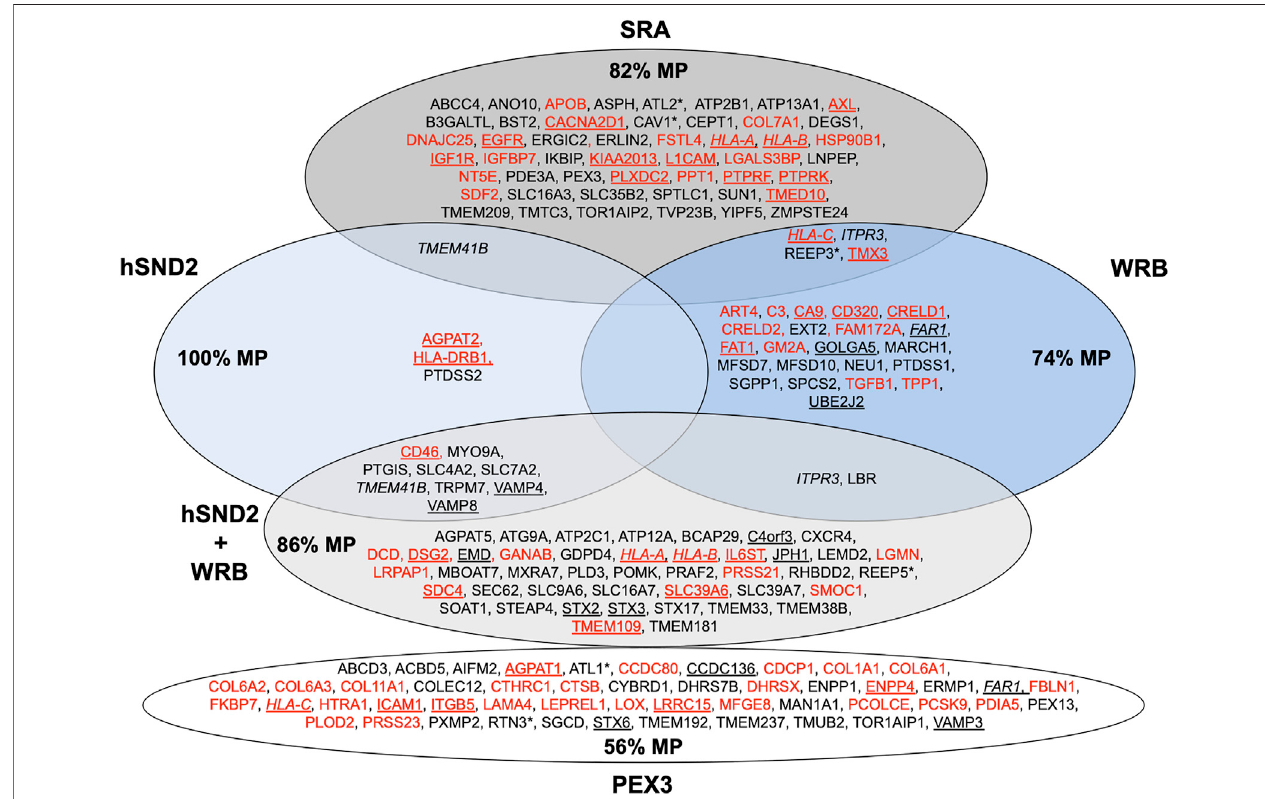
FIGURE 6 | Venn diagram for components for precursor targeting to the human ER membrane and their clients. The diagram summarizes precursors with SP (in red)orTMH(inblack),whicharedestinedtothesecretorypathwayandwerenegativelyaffectedbytheindicateddepletioninHeLacells(Tirincsietal.,2022b)orbyPEX3 depletioninHeLacellsandafterPEX3knock-outinZellwegerpatient fi broblasts(Zimmermannetal.,2021);membraneproteinprecursorswithSPareunderlined,asare TMH proteins with TA. All these precursor polypeptides are de fi ned as potential clients or substrates of the respective component or complex. The percentage of membrane proteins (MP) of the secretory pathway among the respective clients isindicated (%). HLA-Cis in italics tohighlight that itwas negatively affected by PEX3 as well as SRA and WRB depletion, likewise are highlighted FAR1 and HLA-A, HLA-B, ITPR3 plus TMEM41B, respectively. Asterisks indicate hairpin proteins.